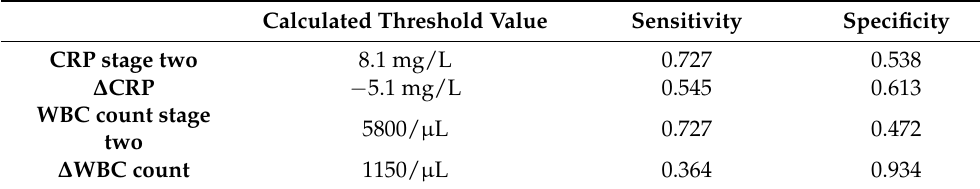
Table 2. Calculated threshold values for C-reactive protein prior to stage two (“CRP stage two“), ∆ CRP (CRP stage two minus CRP stage one), white blood cell count prior to stage two (“WBC count stage two“) and ∆ WBC Count (WBC count stage two minus WBC count stage one).